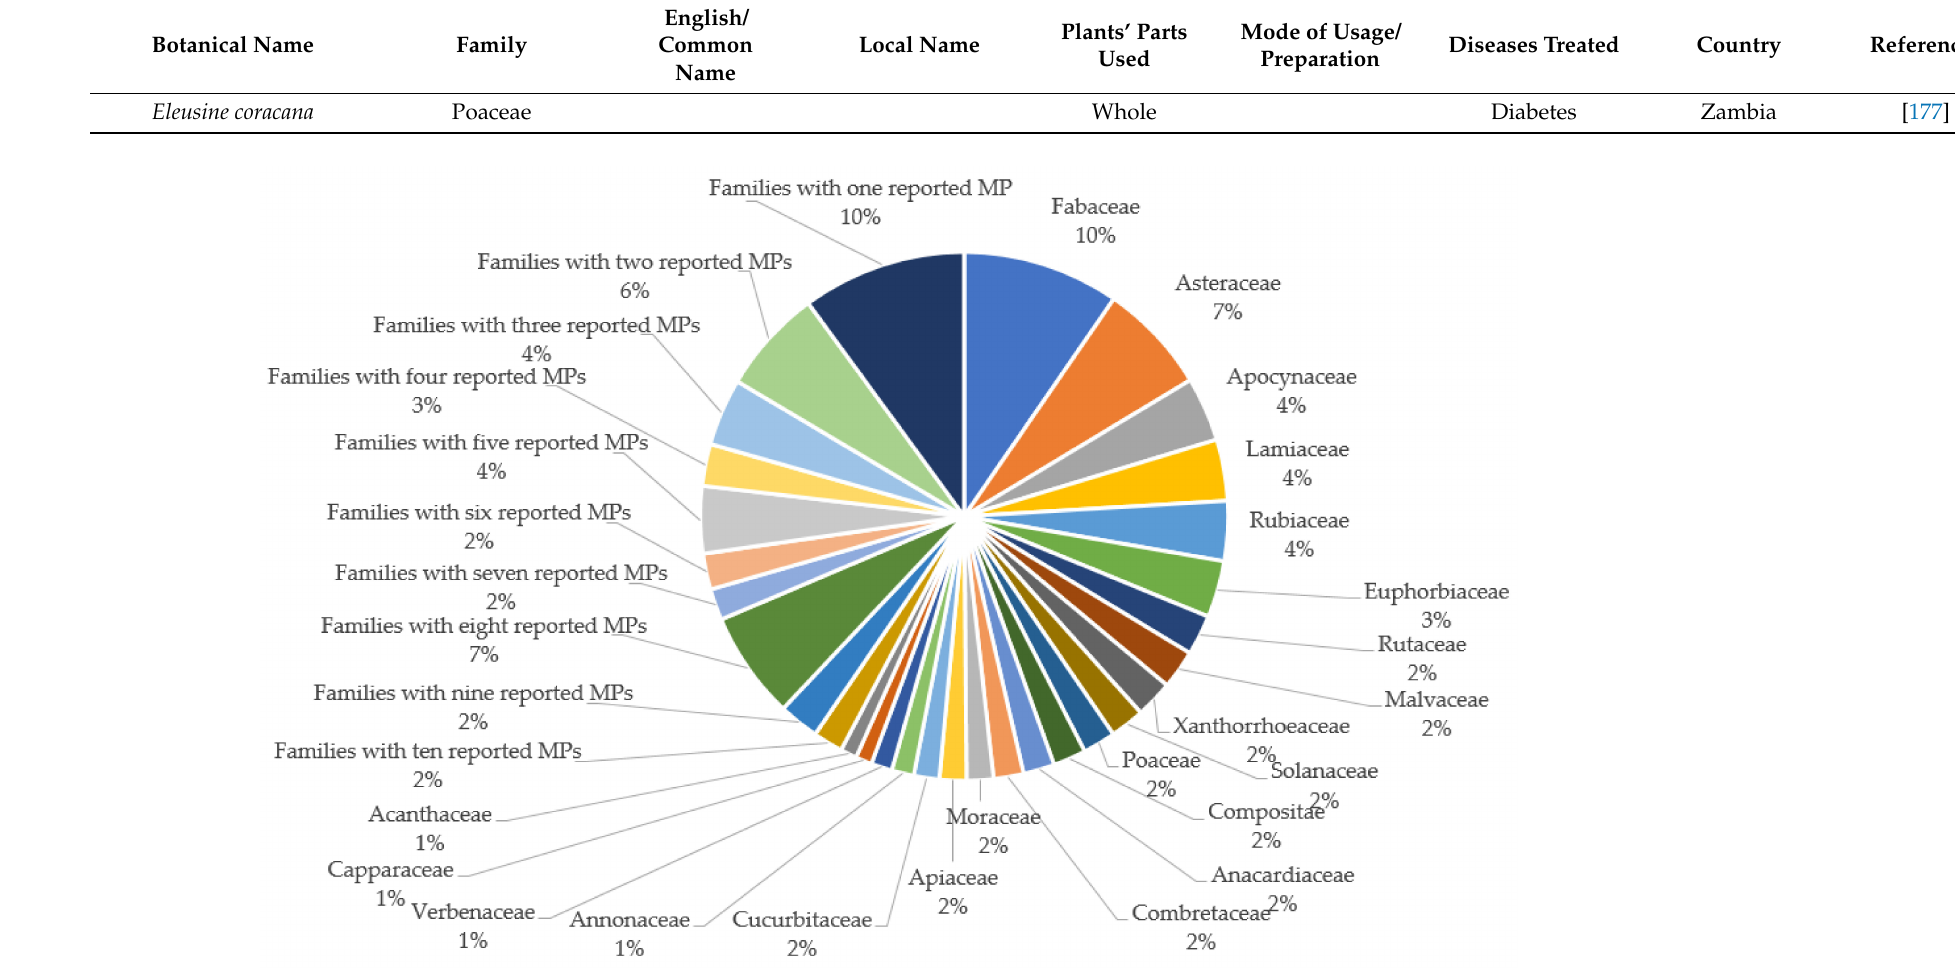
Figure 1. Percentage distribution of families of medicinal plants used in sub-Saharan Africa for cardiovascular diseases